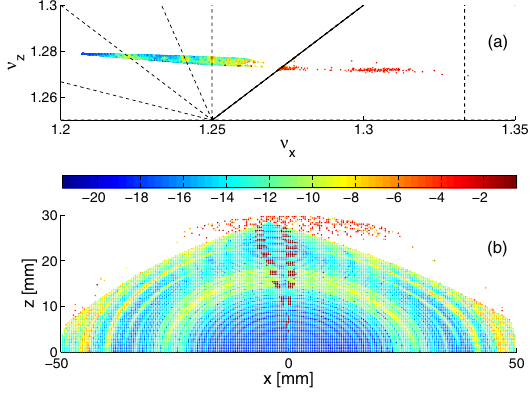
FIG. 6. The frequency map for on-momentum particles of the ideal lattice of the 4.8-m ring. Particles are initially uniformly distributed in the transverse plane. Plot (b) shows the survived particles. The betatron tunes of each survived particle are plotted in the tune space shown in plot (a). The color bar indicates the tune diffusion rates. Particles with smaller diffusion rate are more stable. Some low order resonances are shown on the top plot.